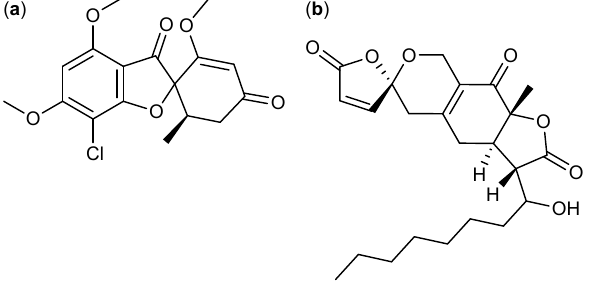
Figure 3. Spiro compounds: ( a ) Griseofulvin, and ( b ) Sequoiamonascin